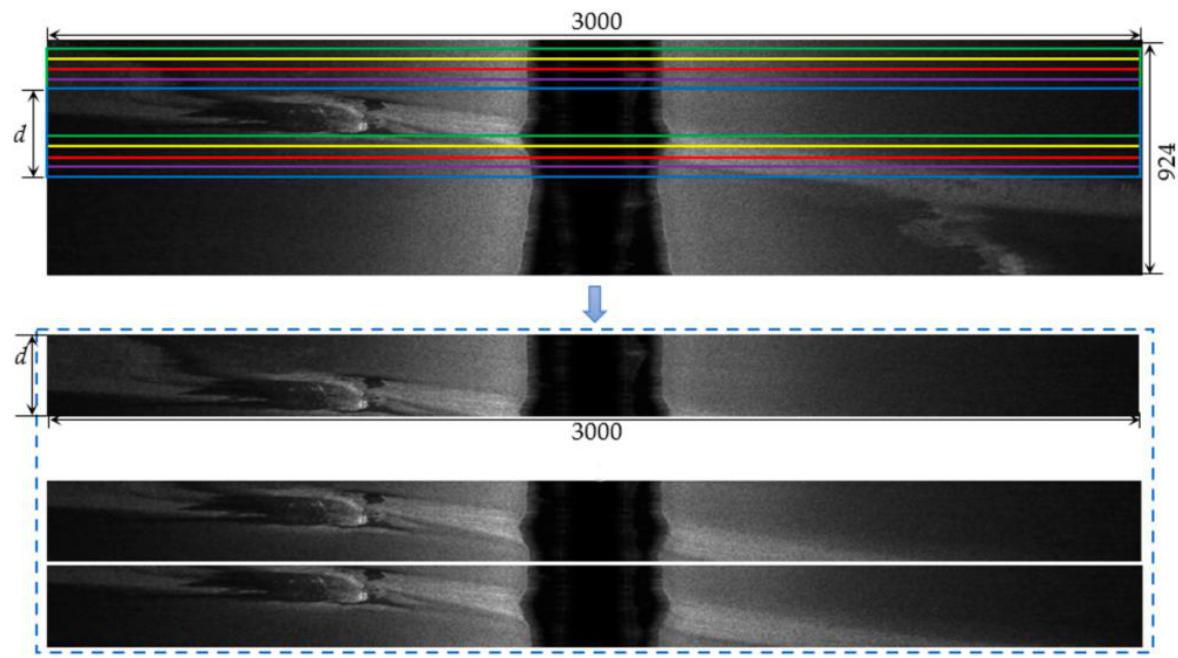
Figure 2. Dense sampling in the along-track direction. The various colors of boxes in the above image denote the sampling operation of which the width is equal to the scanning width of SSS divided by the cross-track resolution and the height is d pixels. The images in the blue dashed line are the sampling results.